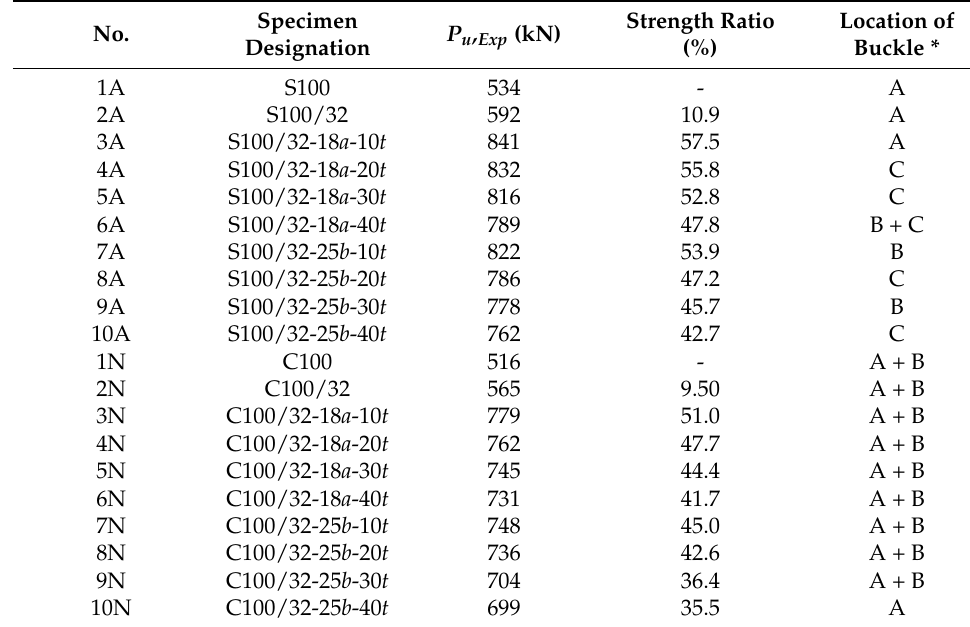
Table 5. Experimental result.